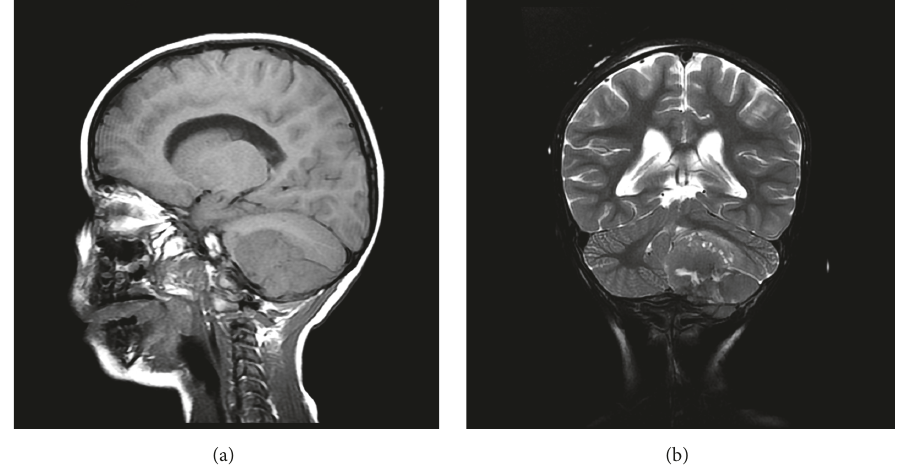
Figure 3: (a) Sagittal T1 weighted image of the brain showing extra-axial durally based solid mass compressing the cerebellum and showing loss of normal cortical bone intensity suggesting invasion of the marrow space. (b) Coronal T2 weighted images showing central necrosis of the mass and compression effect over the fourth ventricle.